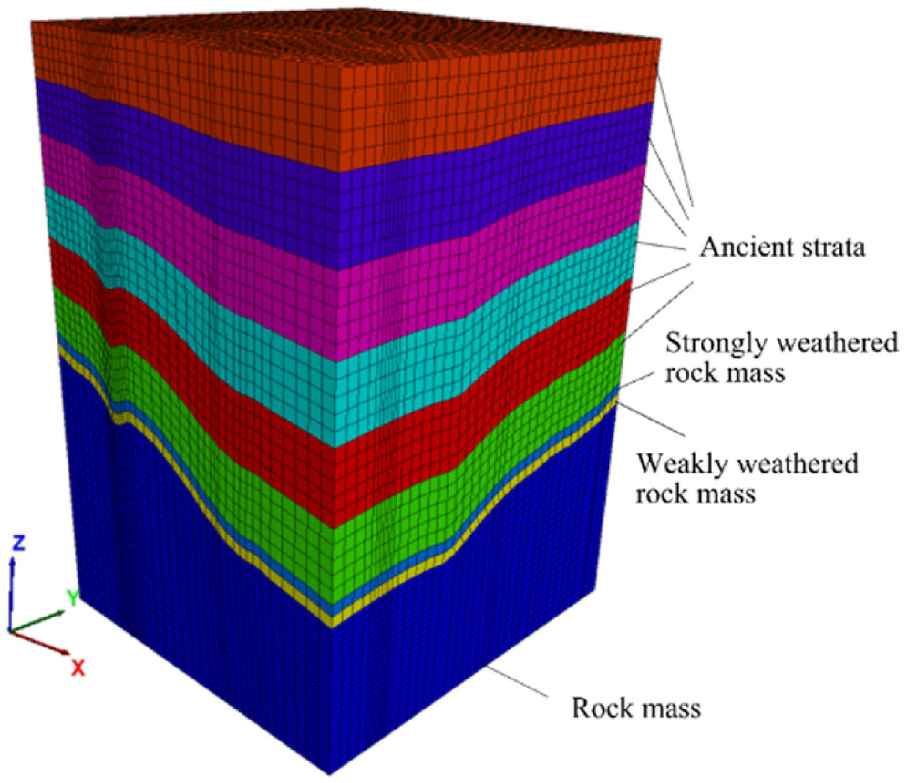
Figure 7. The ancient model.